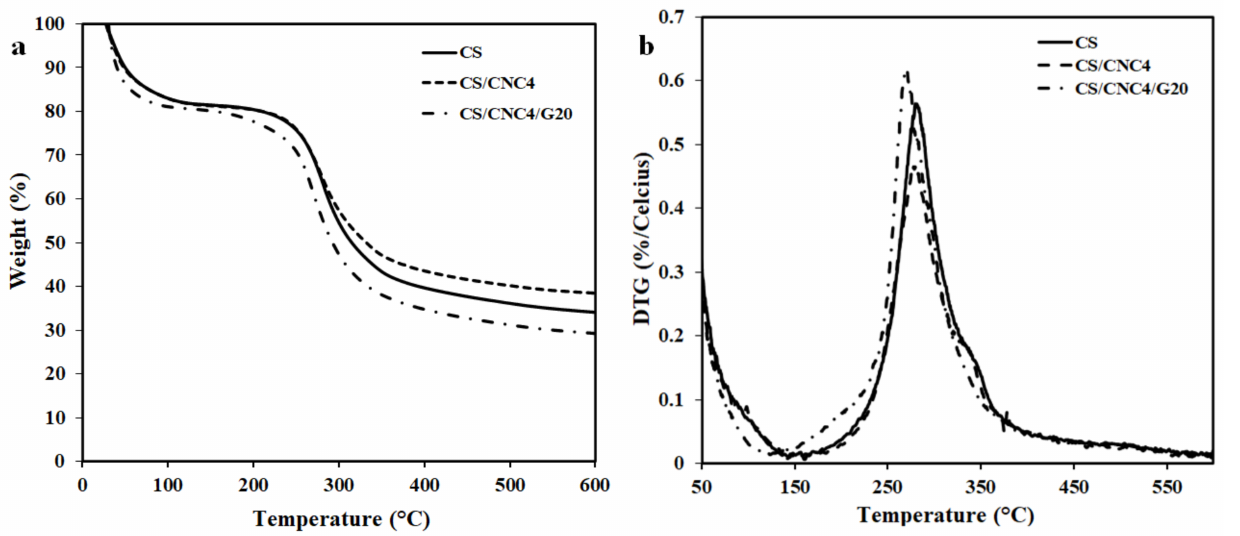
Figure 3. Thermogravimetry analysis (TGA) ( a ) and derivative thermogravimetry analysis (DTG) curves ( b ) of chitosan and its bio-composite